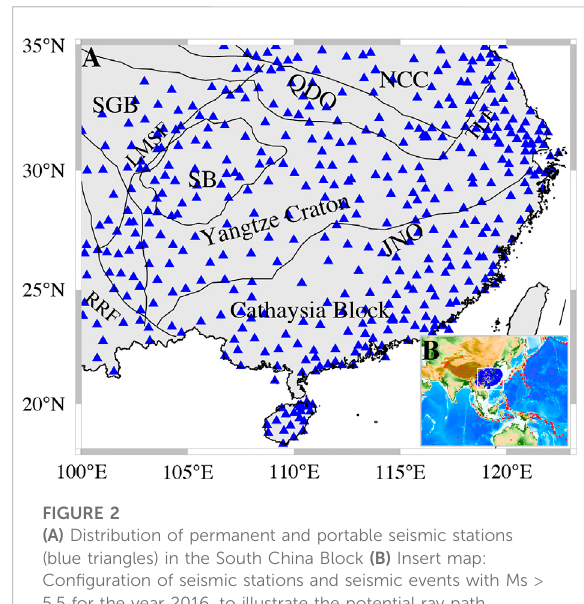
FIGURE 1 Tectonic background of South China Block. TLF, Tanlu fault; RRF, Red River fault; LMSF, Longmenshan fault; NCC, North China Craton; QDO, Qinling-Dabie Orogen; JNO, Jiangnan Orogen; SB, Sichuan Basin; JB, Jiangnan Basin; SGB, Songpan-Gantze Block; TP: Tibetan Plateau.